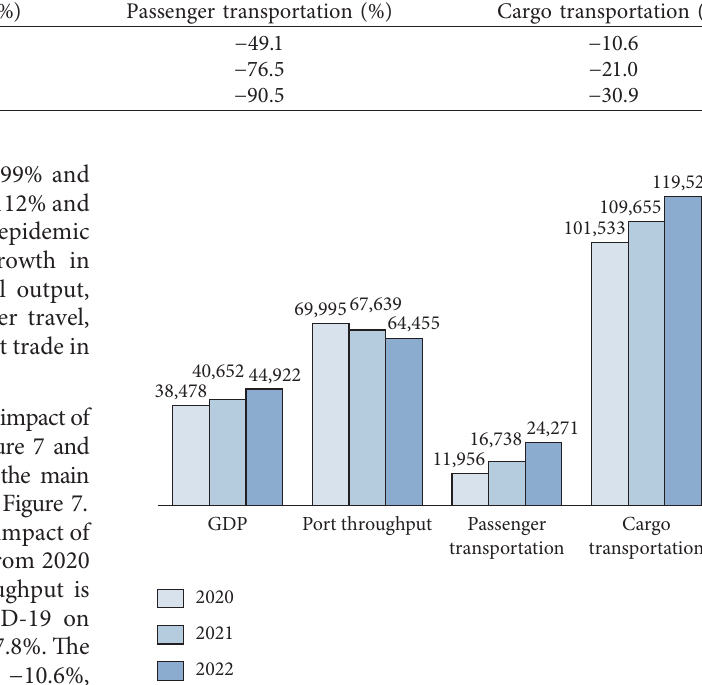
Figure 7: Simulation prediction when COVID-19 is weakened.